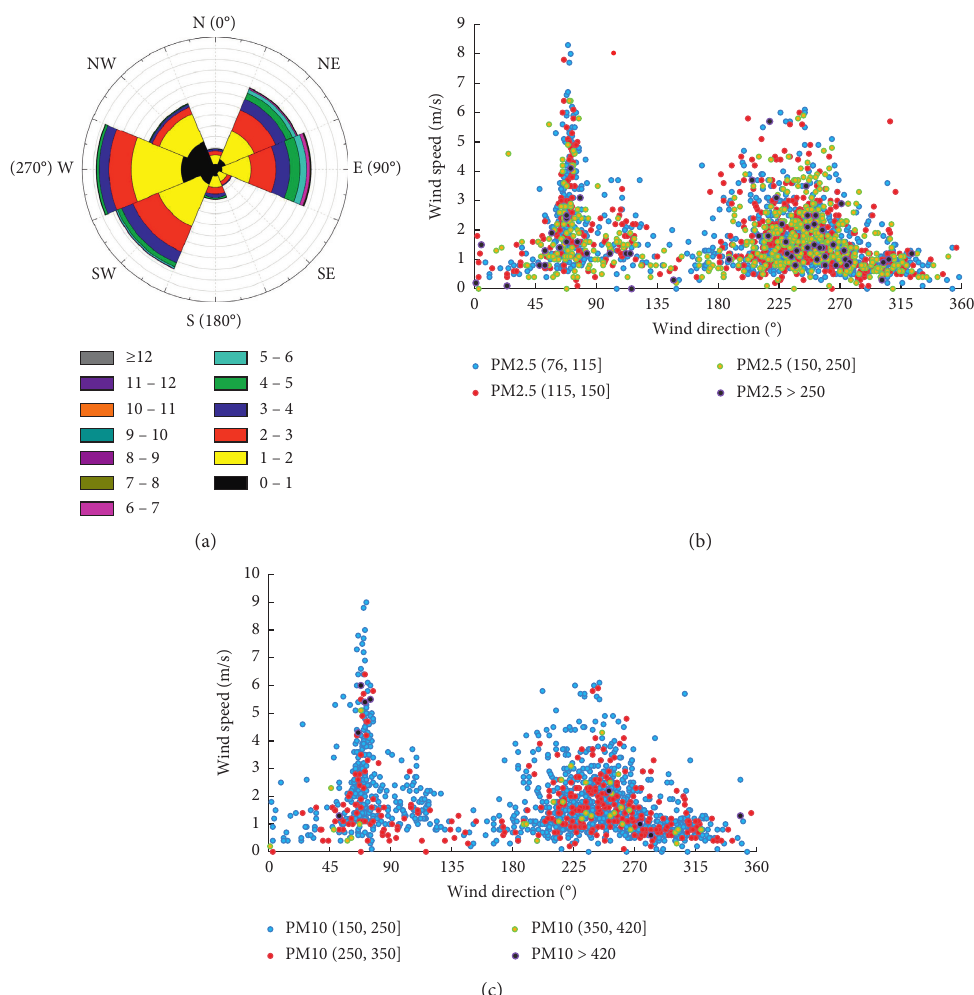
Figure 14: The wind rose diagram at Qinhuangdao. (a) The relationship between PM2.5, (b) PM10, (c) mass concentration, and wind speed and wind direction in